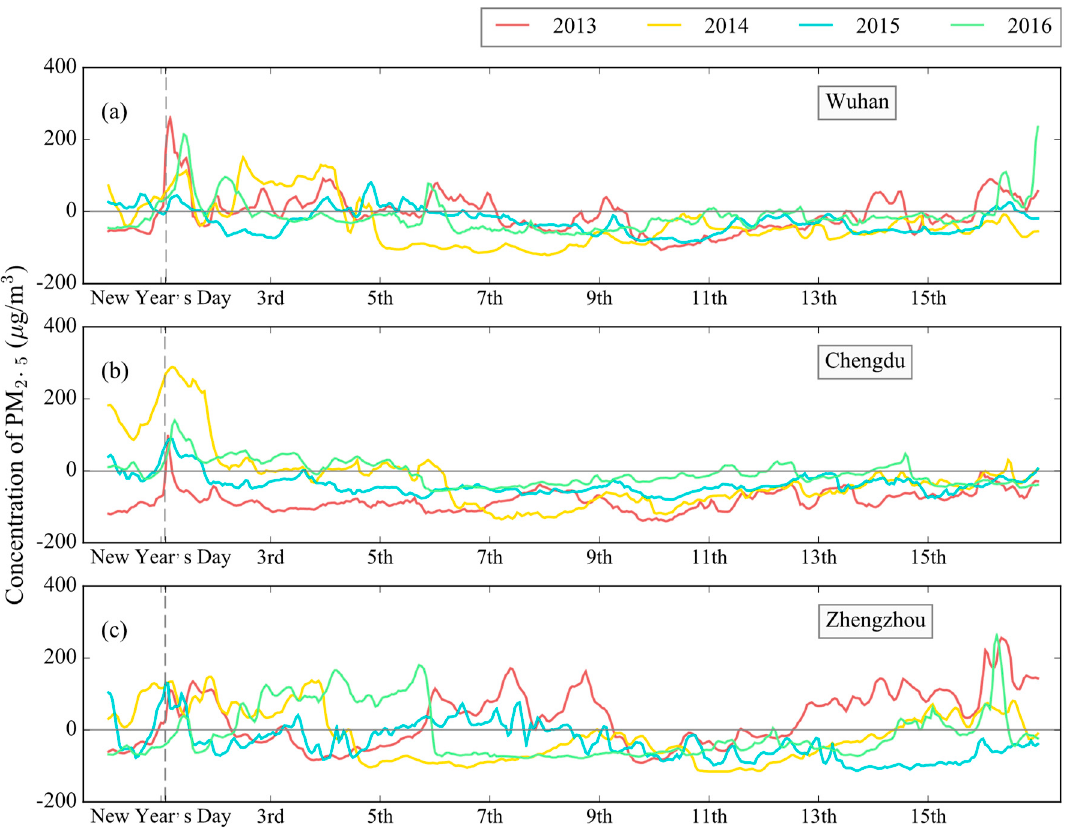
Figure 8. The difference between celebration period hourly PM 2.5 concentrations and the corresponding 34-day average PM 2.5 concentrations for 2013–2016 in ( a ) Wuhan, ( b ) Chengdu, and ( c ) Zhengzhou. The gray dotted line marks 2 a.m. on New Year’s Day.